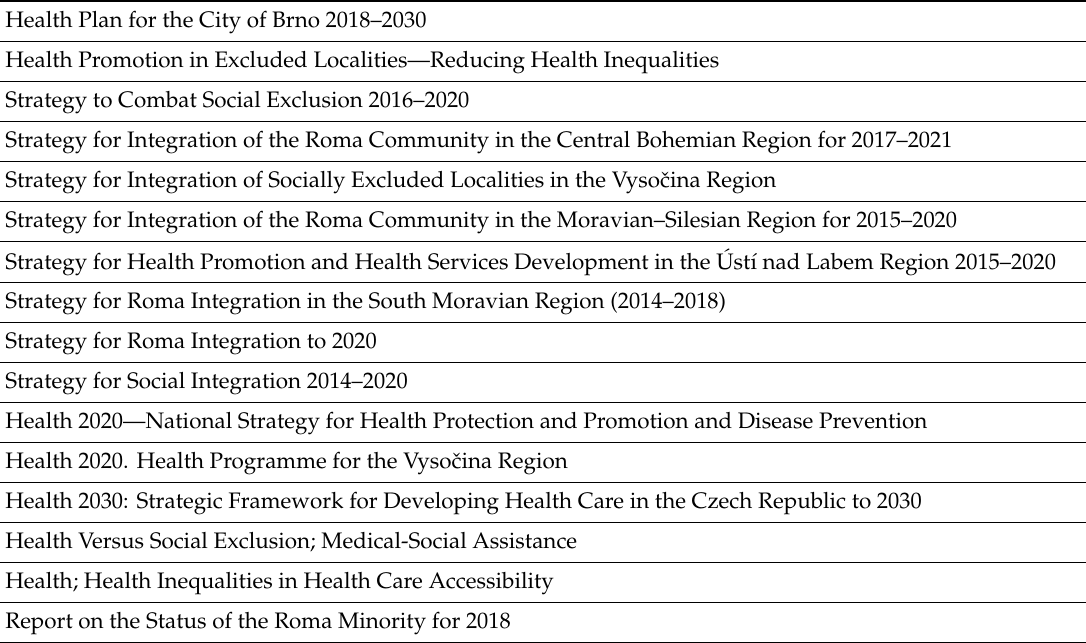
Table 1. List of analyzed